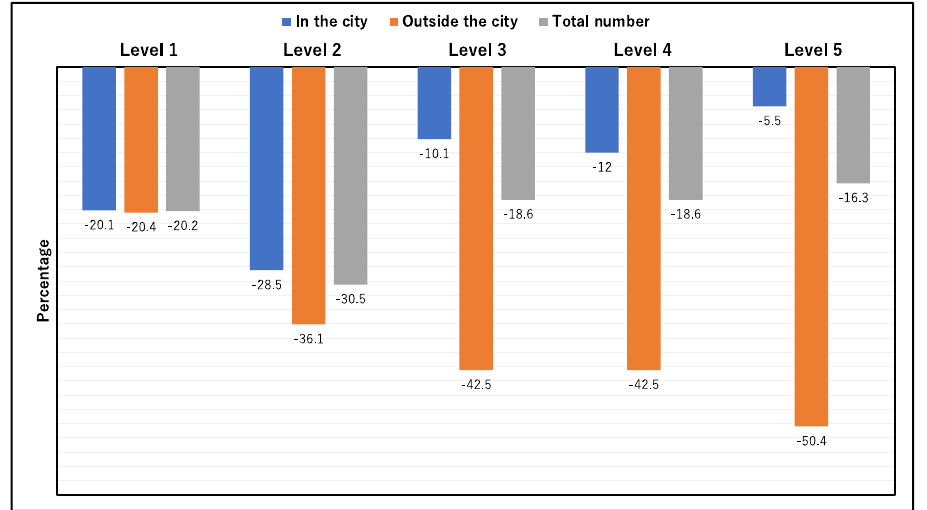
Figure 1. Reduction in the usage of medical care in care-dependent categories from 2018 to 2020.